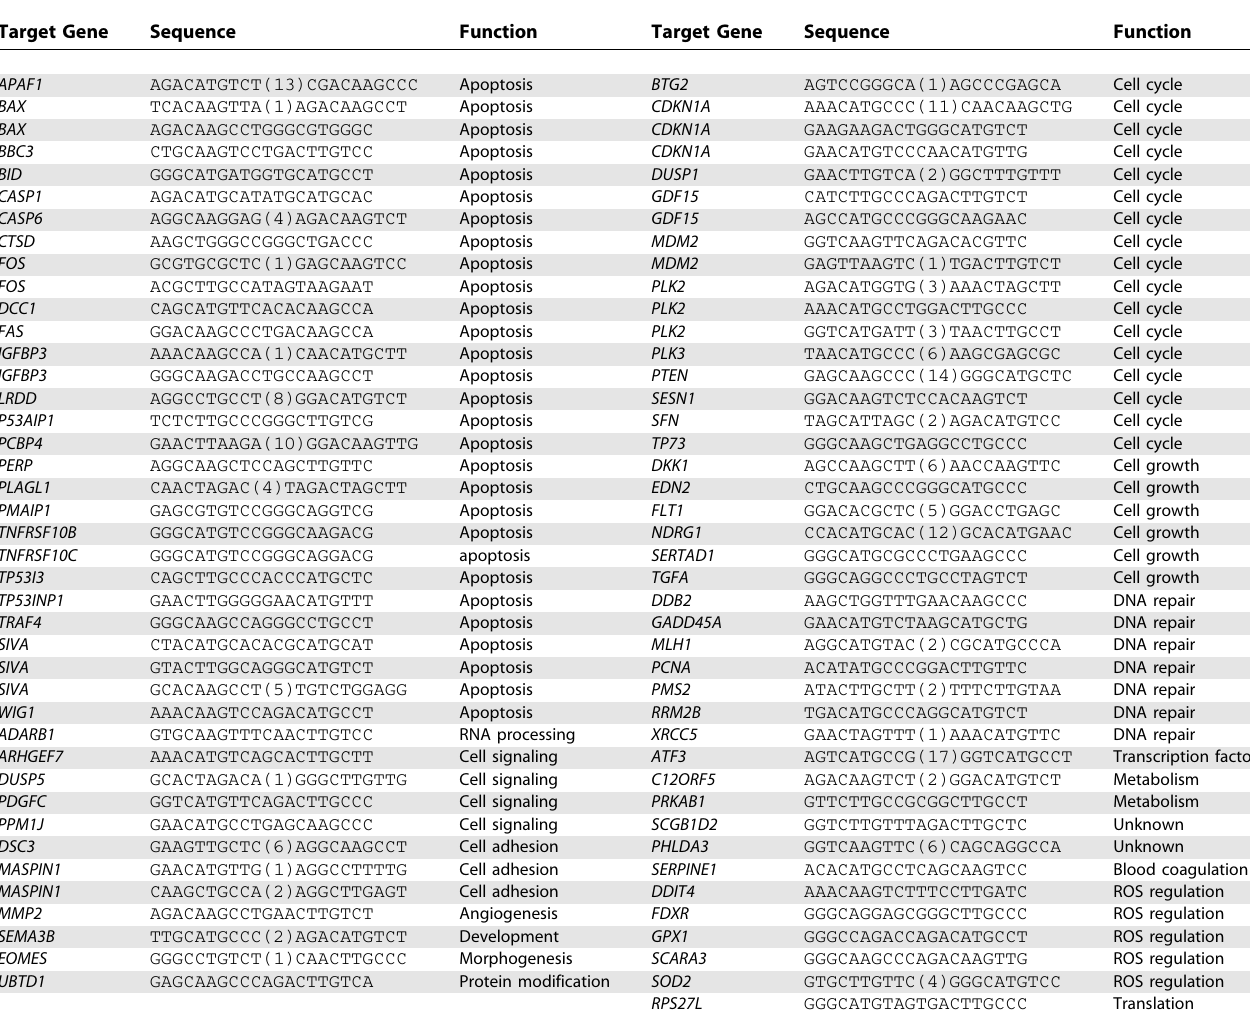
Table 1. Validated Human p53 TFBSs Target Gene